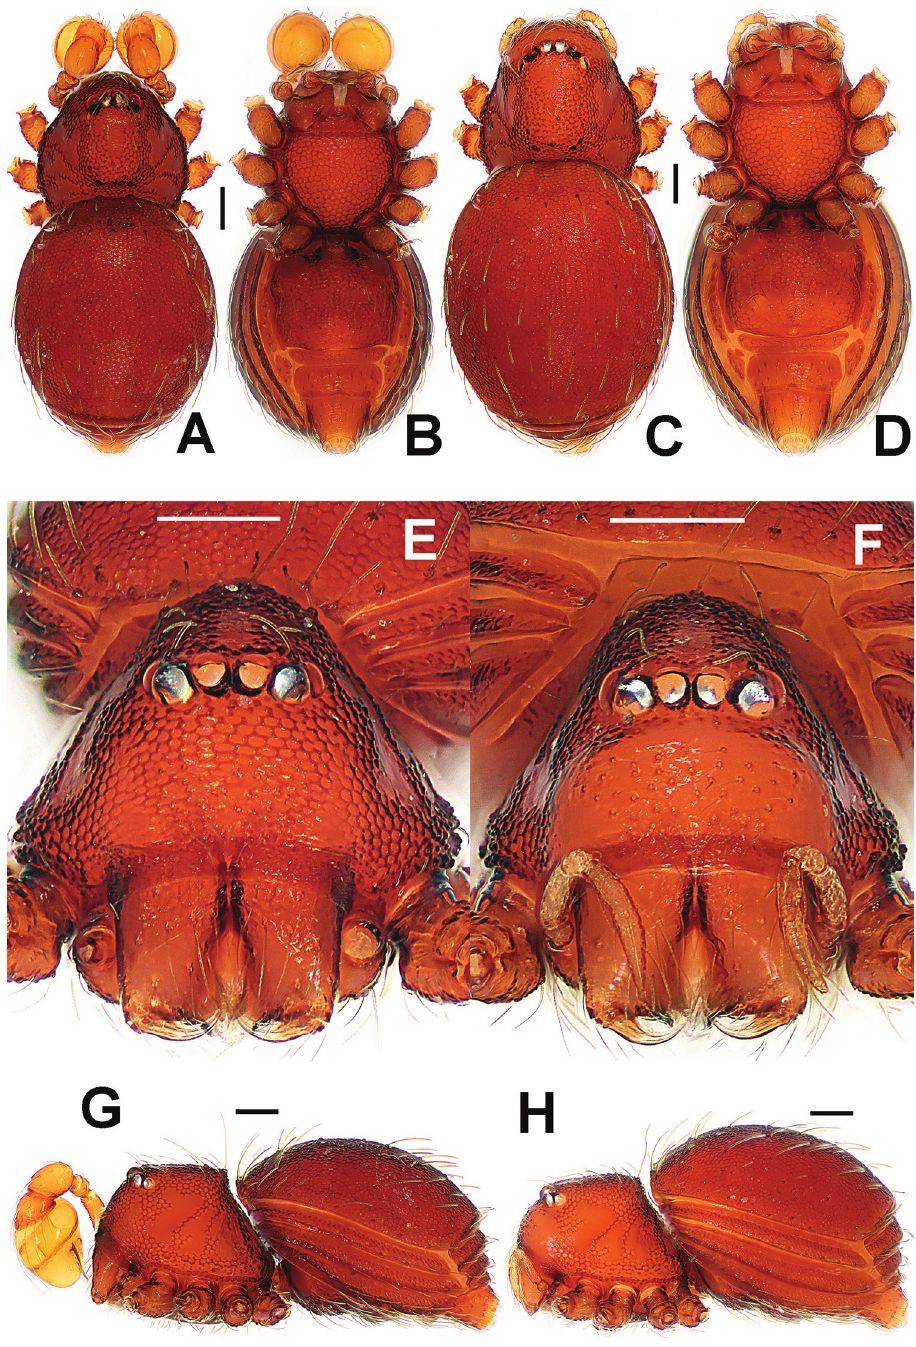
Figure 24. Singaporemma singulare Shear, 1978, male and female specimens from Singapore. A–D, G–H habi- tus E–F prosoma. A, C dorsal B, D ventral E–F anterior G–H lateral. Scale bars: 0.10